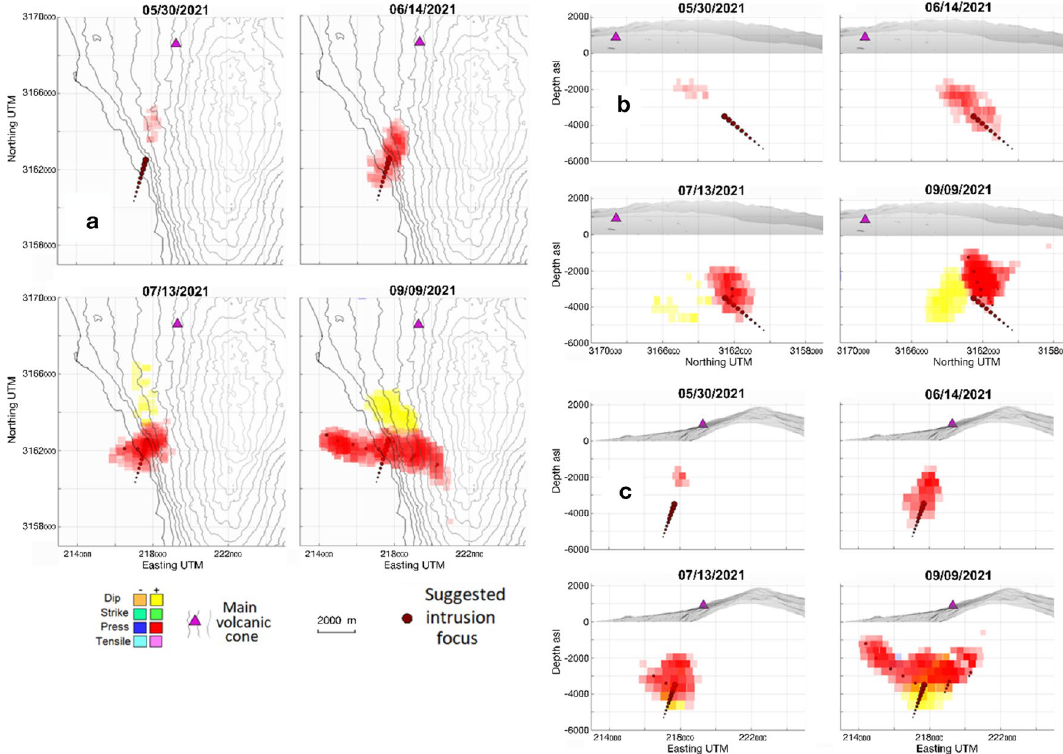
Figure 5. Time evolution of the modeled sources for 01/01/2021–09/13/2021 (2021.00–2021.70). ( a ) Horizontal, ( b ) vertical N-S and ( c ) vertical W-E projections of the sources obtained for different epochs in 2021.00–2021.70. The different plots show the time evolution of the different sources obtained from inversion of Sentinel-1 ascending and descending LOS displacement. Purple triangle shows the location of the main volcanic vent during the 2021 La Palma eruption. Red dots indicate the provenance of the deep magma feed in the detected shallow reservoir from the geodetic modeling. All coordinates and depths are in meters. Matlab (www. mathw orks. com) and GMT (www. gener ic- mapin- tools. org) softwares were used to create this figure. This figure complements with Supplementary Movies